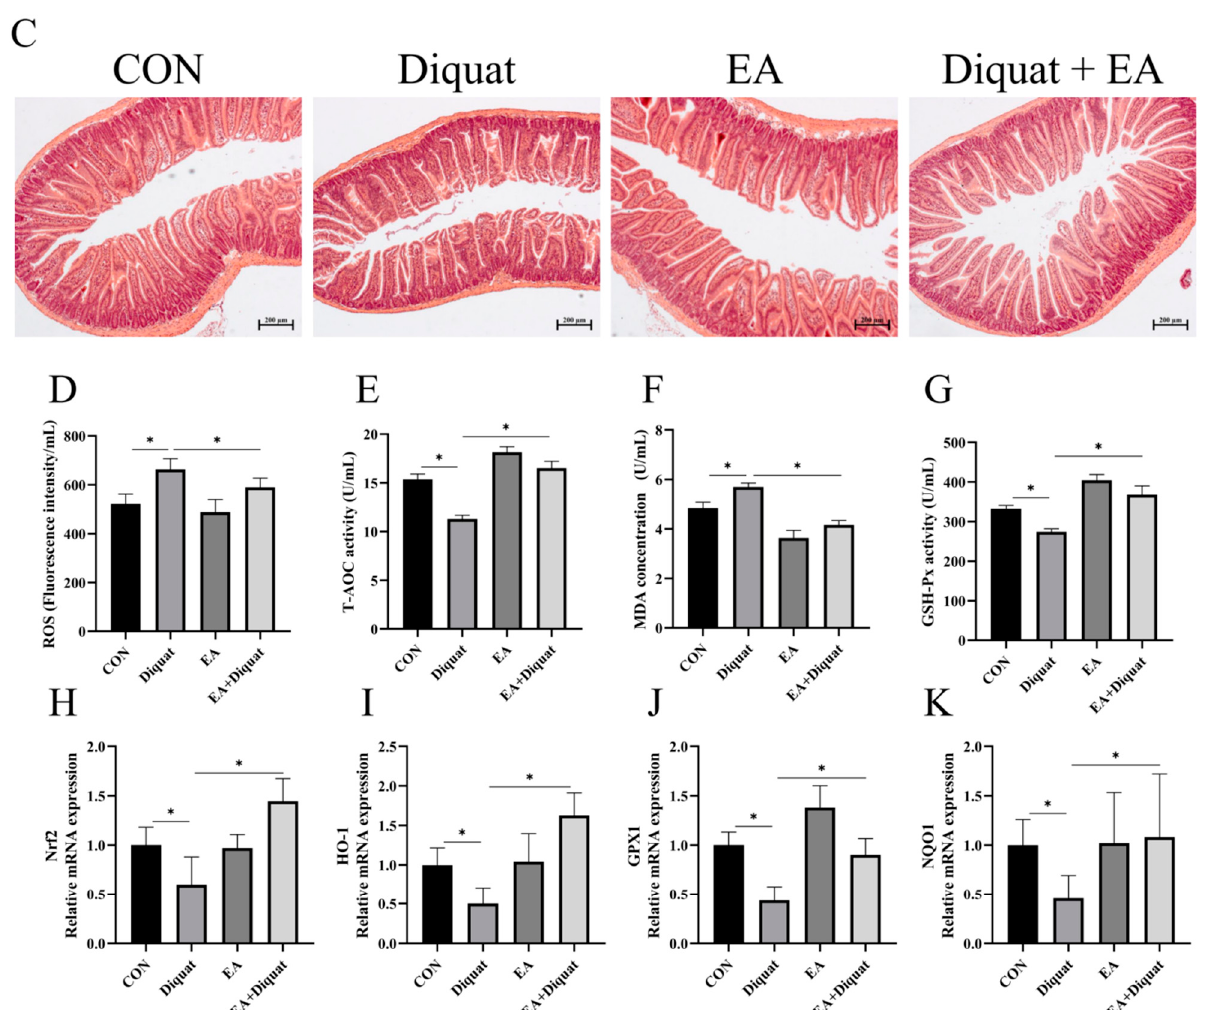
Figure 5. Effects of EA pre-treatment on oxidative stress induced by diquat. ( A ) Experimental group- ing scheme. ( B ) Body weight curve of mice. ( C ) HE staining of the jejunum. ( D ) The fluorescence intensity of ROS in serum. ( E ) T-AOC in serum. ( F ) MDA concentration in serum. ( G ) GSH-Px activity. ( H–K ) The mRNA expression of Nrf2, HO-1, GPX1 and NQO1. All data were presented as mean ± S.E.M ( n = 6). # means that this group had a significant difference compared with the Diquat group. *** means p < 0.001 when this group is compared with the CON group. * means p < 0.05 between the two groups. PBS, phosphate buffer saline; CON, control; EA, ellagic acid; ROS, reactive oxygen species; T-AOC, total antioxidant capacity; GSH-Px, glutathione peroxidase; MDA, malondi- aldehyde; Nrf2, nuclear factor erythroid 2-related factor 2; NQO-1, NADPH dehydrogenase-1; GPX1, glutathione peroxidase 1; HO-1, heme